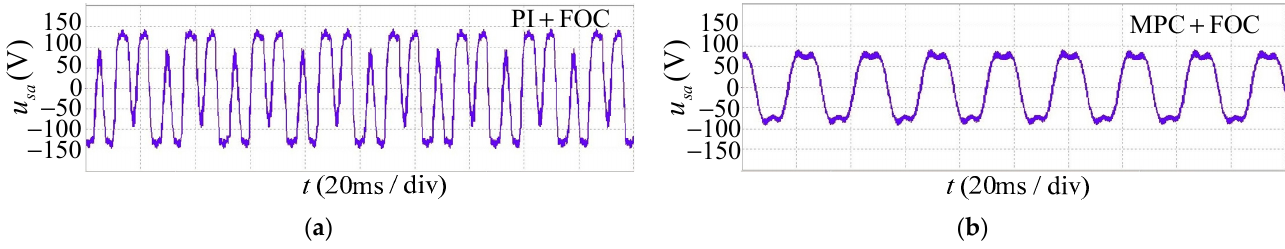
Figure 8. Current tracking error of two control methods: ( a ) tracking error of i sq 1 and i sq 3 under PI+FOC; and ( b ) tracking error of i sq 1 and under MPC+FOC.